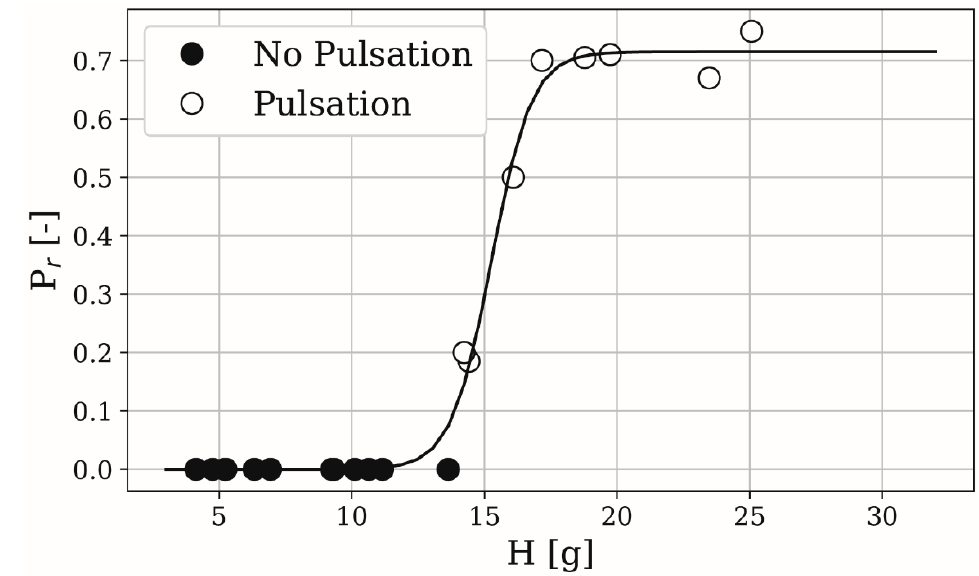
Figure 9. Characterization of mass flow pulsations by fitting a logistic function (L = 0.715, x 0 = 15.268, k = 1.327), where white markers are experiments with a second peak and black markers without.